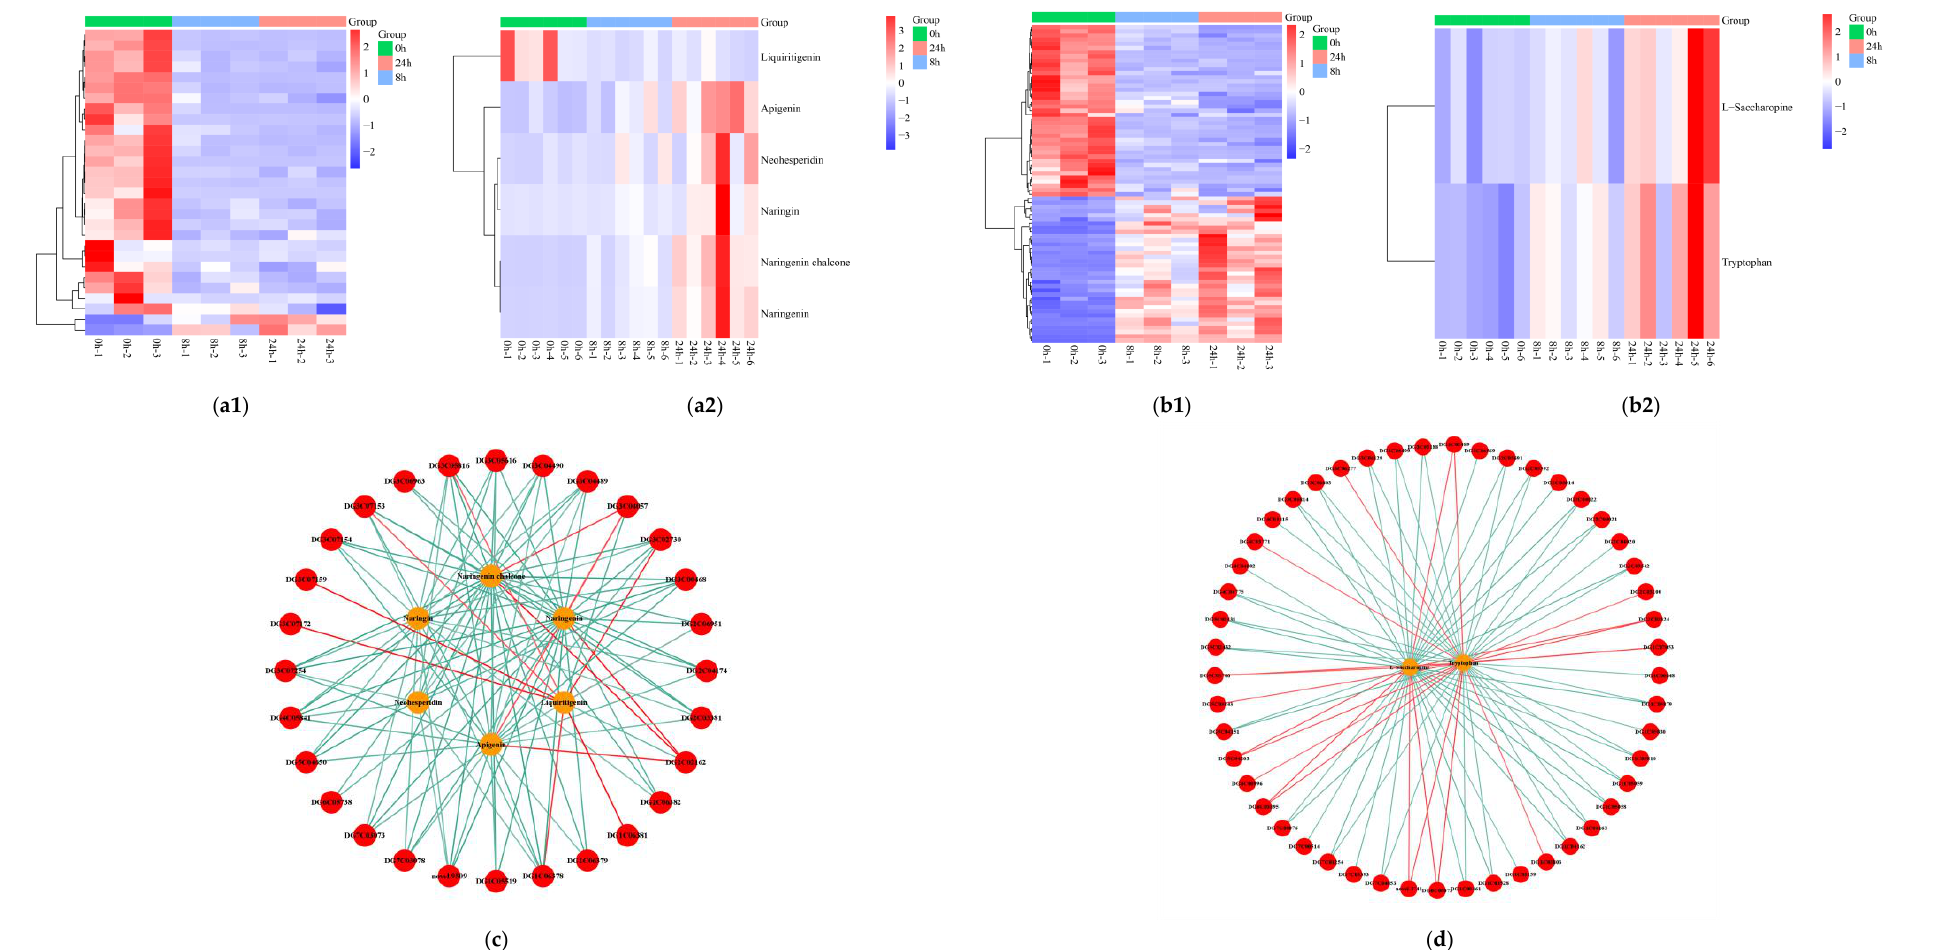
Figure 8. Analysis of differentially expressed genes (DEGs) and differentially expressed metabolites (DEMs) involved in biosynthesis of flavonoid and amino acids in the roots of orchardgrass under submergence stress. Expression pattern of DEGs and DEMs involved in flavonoid biosynthesis ( a1 , a2 ) and amino acids ( b1 , b2 ). Correlation network of DEGs and DEMs involved in flavonoid biosynthesis ( c ) and amino acids ( d ). Red circles indicate genes and yellow circles indicate metabolites. Lines colored in “red” and “green” represent positive and negative correlations, respectively.